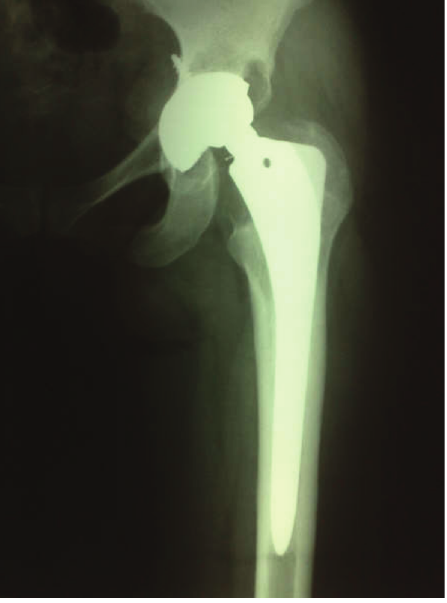
Figure 2 - A plasmacup acetabular component with severe polyethylene wear and